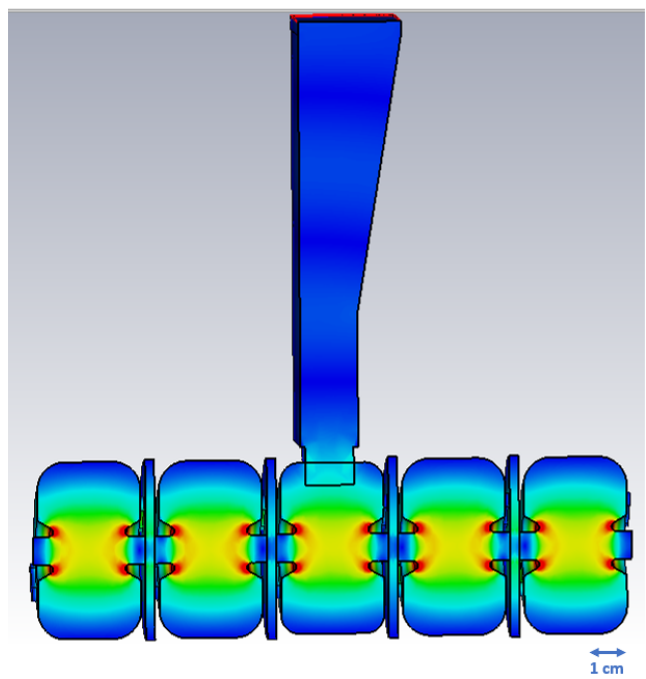
Figure 4. 3D electric field contour inside the volume of the